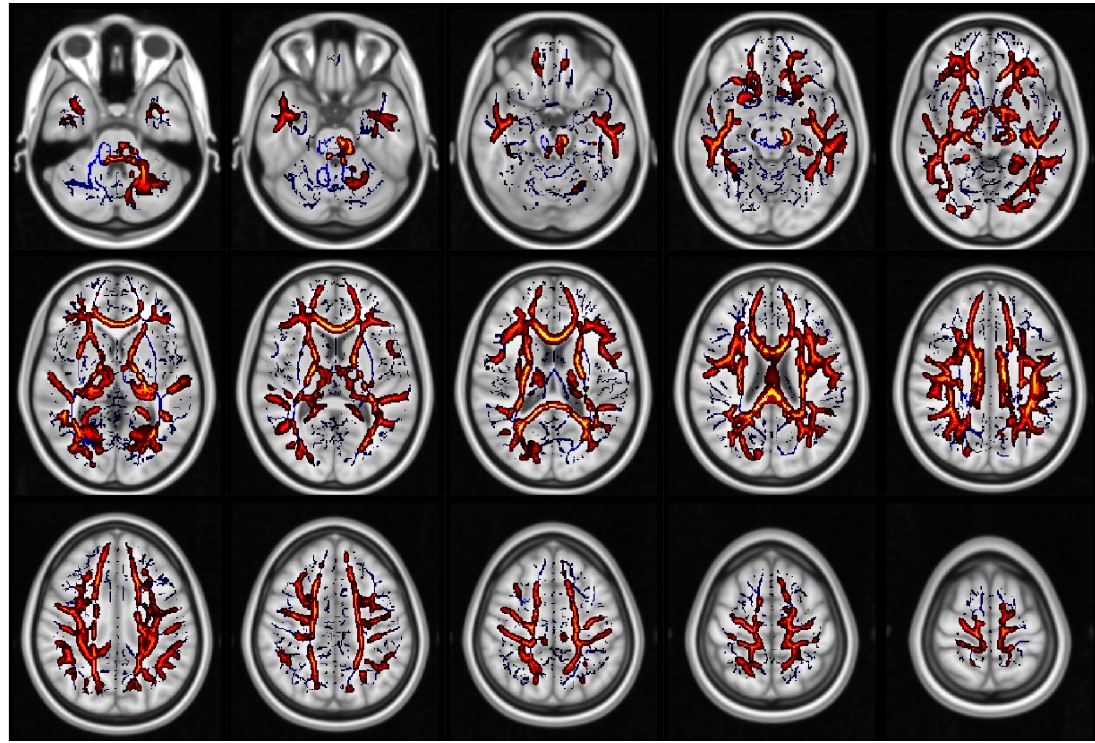
Figure 3. Regions which displayed significant differences in mean kurtosis (MK) (displayed as red and yellow) (CTRL) > glaucoma group (GLA)). The white matter skeleton is shown in blue. J. Clin. Med. 2020 , 9 , x FOR PEER REVIEW